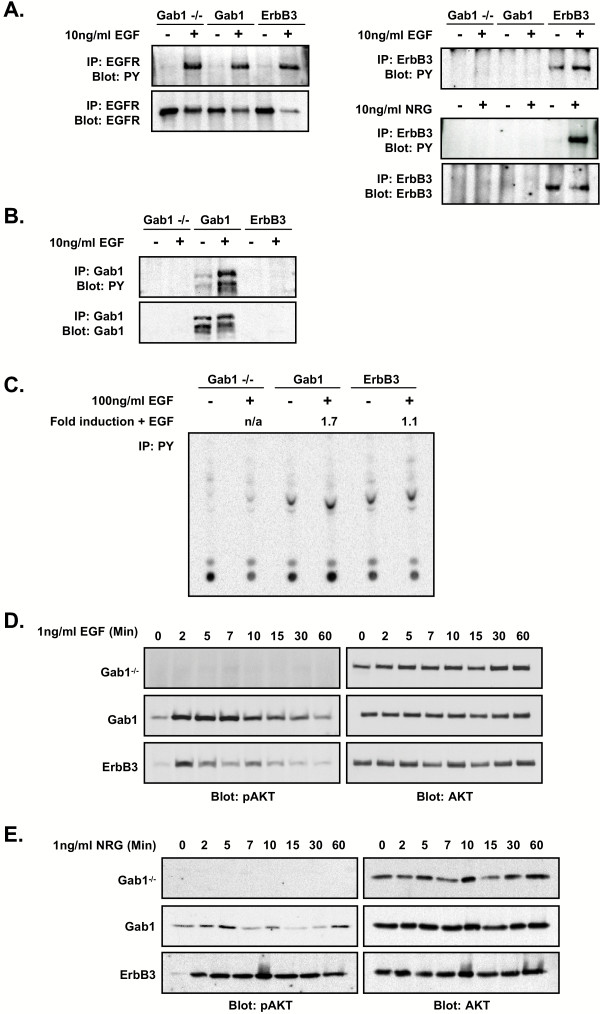
Expression of ErbB3 in Gab1-deficient MEFs partially rescues EGF-induced activation of the PI-3 kinase/Akt signaling pathway. A. The indicated cell lines were serum-starved for 24 hours and stimulated with 10 ng/ml EGF for five minutes at 37°C. Cell extracts were analyzed for EGFR tyrosine phosphorylation and EGFR expression, and for ErbB3 tyrosine phosphorylation and ErbB3 expression. Cells were additionally stimulated with 10 ng/ml NRG and cell extracts analyzed for ErbB3 tyrosine phosphorylation. The endogenous EGFR is tyrosine phosphorylated in response to EGF in all cell lines. ErbB3 exhibits weak constitutive tyrosine phosphorylation that is enhanced by NRG treatment, but is not significantly enhanced by treatment with EGF. Selected bands were quantitated by densitometry to determine relative increase in growth factor-induced tyrosine phosphorylation. B. The indicated cell lines were serum-starved for 24 hours and stimulated with 10 ng/ml EGF for five minutes at 37°C. Cell extracts were analyzed for Gab1 tyrosine phosphorylation and Gab1 expression. Cells rescued with wild type Gab1 exhibit Gab1 tyrosine phosphorylation in response to EGF treatment, while Gab1 -/- cells and Gab1-deficient cells expressing ErbB3 do not. C. The indicated cell lines were serum-starved for 24 hours and stimulated with 100 ng/ml EGF for five minutes at 37°C. Cell extracts were prepared and phosphotyrosine immunoprecipitates were analyzed for PI-3 kinase activity. Expression of wild type Gab1 in Gab1-deficient MEFs rescues the EGF-induced PI-3 kinase activity. Gab1 deficient MEFs exogenously expressing ErbB3 exhibit PI-3 kinase activity that is largely EGF-independent. D. The indicated cell lines were serum-starved for 24 hours and stimulated with 1 ng/ml EGF for varying periods of time at 37°. Cell extracts were analyzed for activation of Akt by using antibodies that specifically recognize the phosphorylated form of Akt. Membranes were subsequently stripped and immunoblotted for Akt to confirm equal loading. Ectopic expression of ErbB3 in Gab1 deficient cells results in a partial rescue of EGF-induced Akt activation relative to cells expressing wild type Gab1. E. The indicated cell lines were serum-starved for 24 hours and stimulated with 1 ng/ml NRG for varying periods of time at 37°C. Cell extracts were analyzed for activation of Akt by using antibodies that specifically recognize the phosphorylated form of Akt. Membranes were subsequently stripped and immunoblotted for Akt to confirm equal loading. Treatment of Gab1-deficient cells exogenously expressing ErbB3 with NRG results in a robust and sustained activation of Akt, while cells expressing exogenous Gab1 do not exhibit Akt activation in response to NRG treatment.